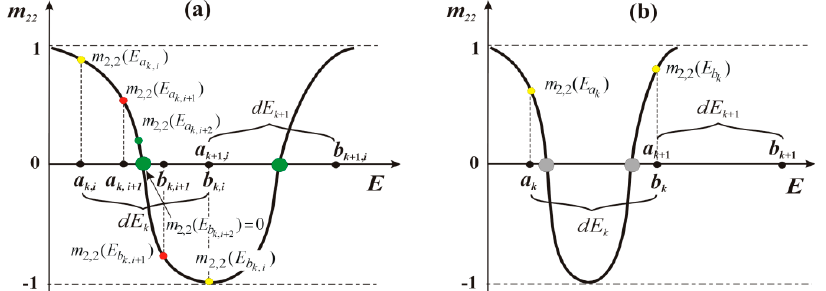
Figure 5. Schematic illustration of the standard BM engaged in the process of finding the zeros of the m 2,2 ( E ) function: ( a ) an appropriately selected energy discretisation step dE k ensures the sign of the function at the ends of the dE k = < a k , b k > segment to be changed and the specific segment to include the root, which can be found in the next iterative step ( i + 2); ( b ) for dE k values that are too large the sign of the m 2,2 ( E ) function does not change and the zeros are not found.